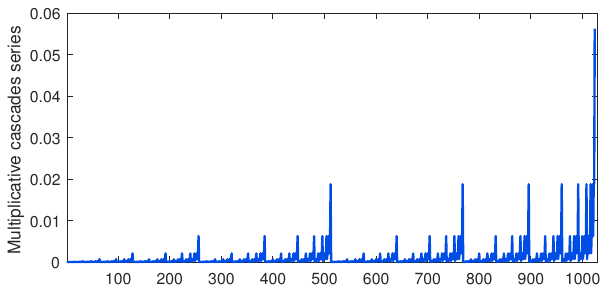
Figure 1. Multiplicative cascades series under p -model with p = 0.75 and n max =